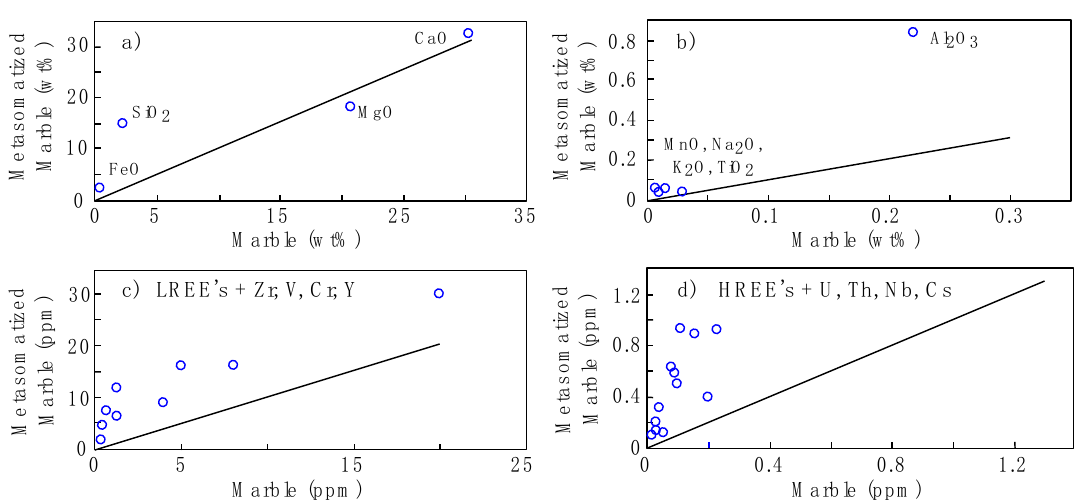
Figure 11. Deviation of major and trace elements and REEs from the isocon (straight line). ( a ) Deviation of SiO 2 , FeO, MgO, CaO; ( b ) Deviation of Al 2 O 3 , MnO, Na 2 O, K 2 O, TiO 2 ; ( c ) Deviation of LREE’s and Zr, V, Cr, Y ; ( d ) Deviation of HREE’s and U, Th, Nb, Cs.